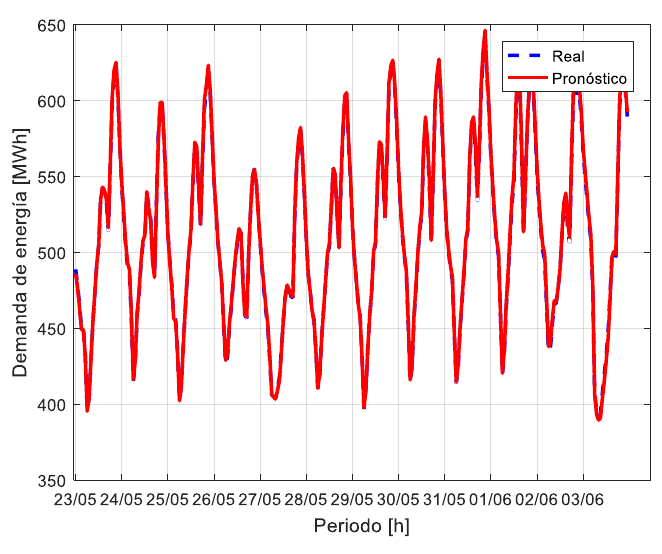
Figure 21. Forecasting energy demand for Market